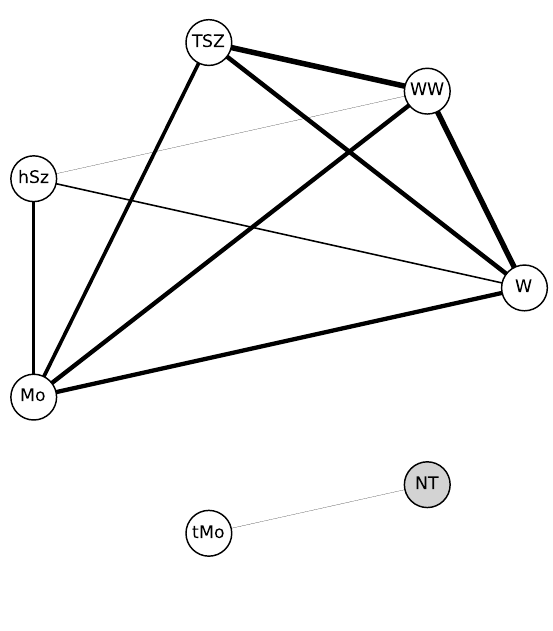
Figure 2: Correlation graph.